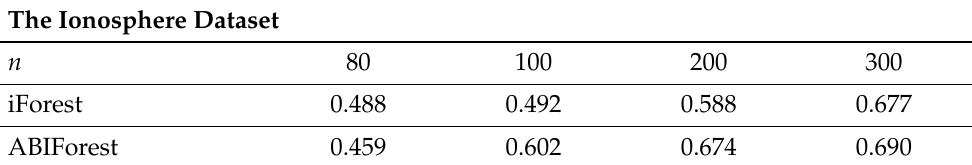
Table 8. F1-score measures of the original iForest and ABIForest as functions of the number of instances n in the Ionosphere dataset under the condition that the ratio of normal and anomalous instances was not changed.